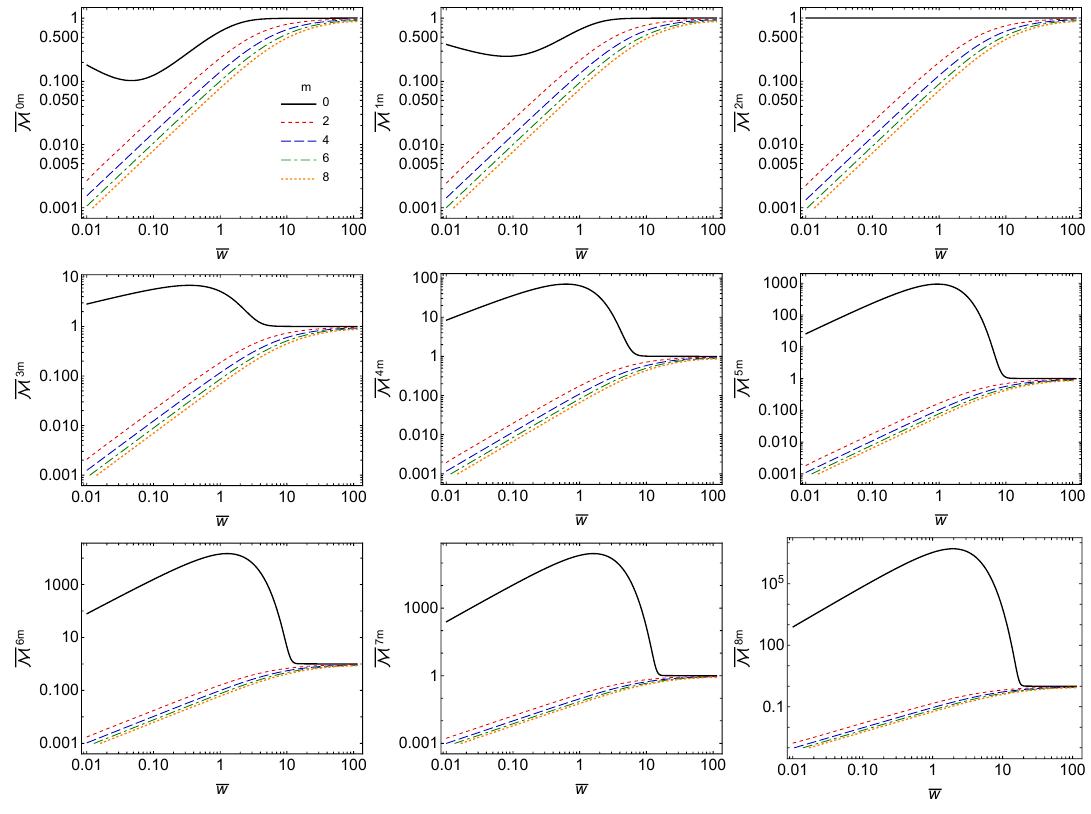
Figure 5 . Scaled moments M nm obtained from the exact attractor solution. Panels show n 2 f 0 (cid:1) (cid:1) (cid:1) 8 g and inside each panel the set of lines correspond to m 2 f 0 (cid:1) (cid:1) (cid:1) 8 g .